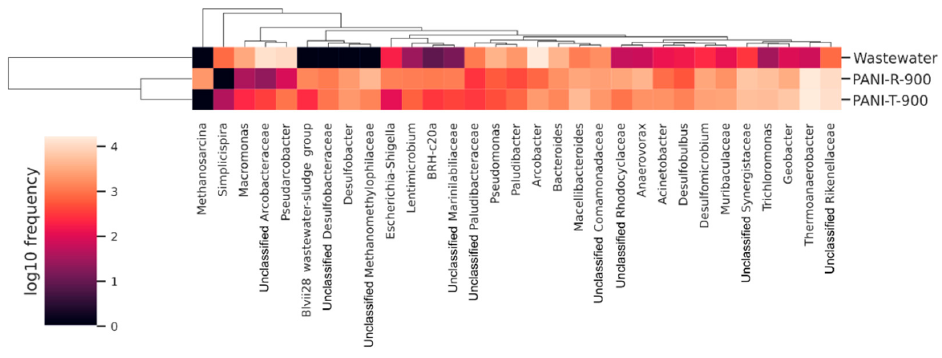
Figure 6. Heatmap representation of genera of at least 1% relative abundance, log normalized. Samples and features were clustered based on Bray-Curtis distances. Relative frequencies represent the mean-ceiling of triplicate datasets.